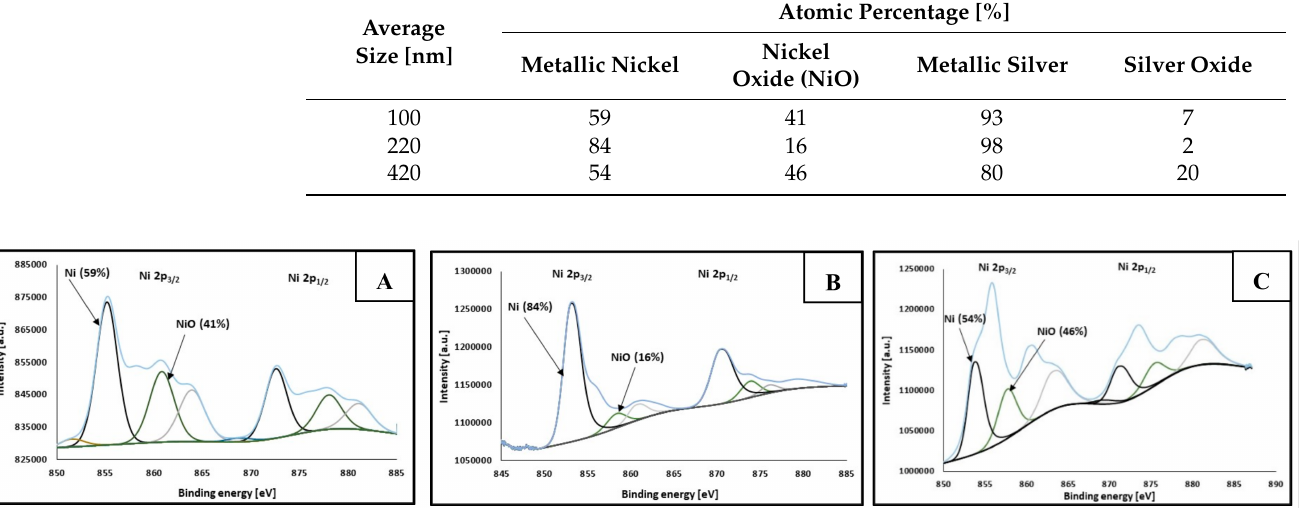
Figure 7. XPS spectra of Ni-Ag NPs with different sizes—analysis of nickel: ( A ) 100 nm, ( B ) 220 nm, ( C ) 420 nm (metallic Ni—black curves, NiO—green curves, satellite—grey